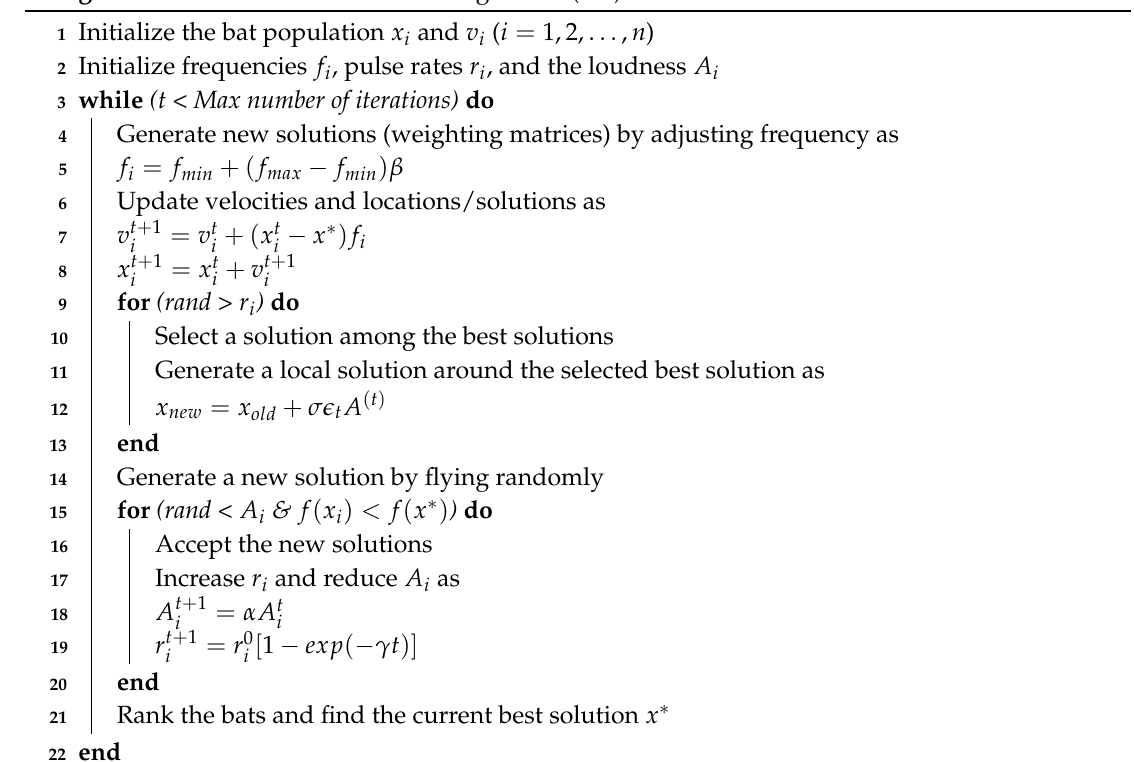
Algorithm 1: Pseudo code of the bat algorithm (BA)